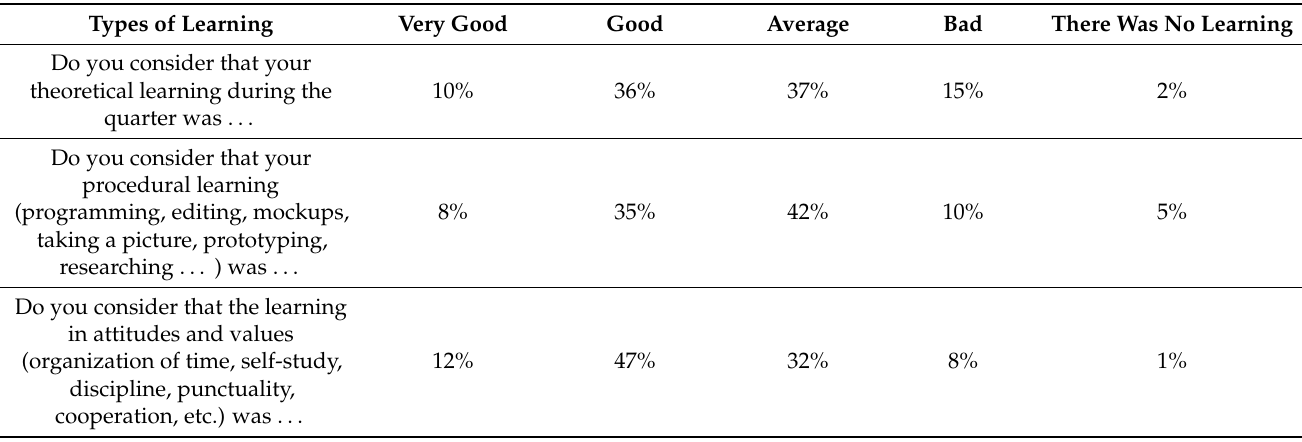
Table 2. Levels of appropriation in